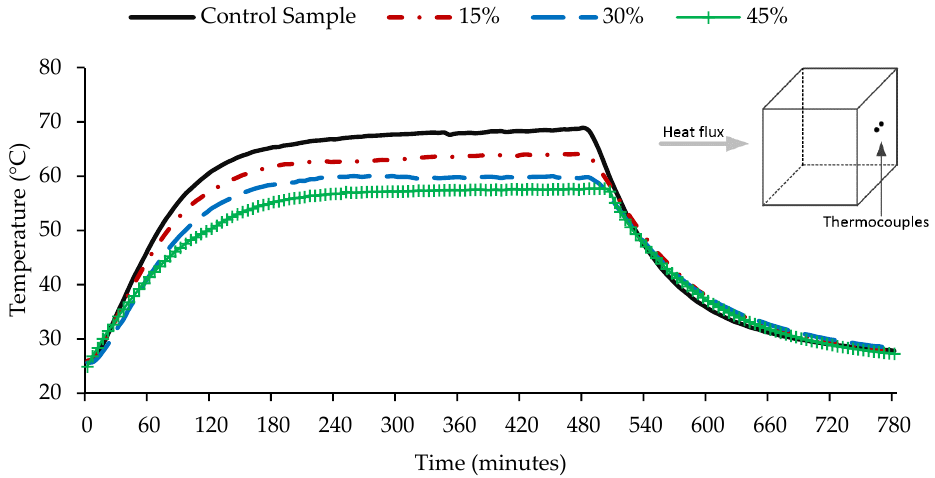
Figure 5. Comparison of the back-surface temperatures for 15%, 30%, 45% with the control sample.